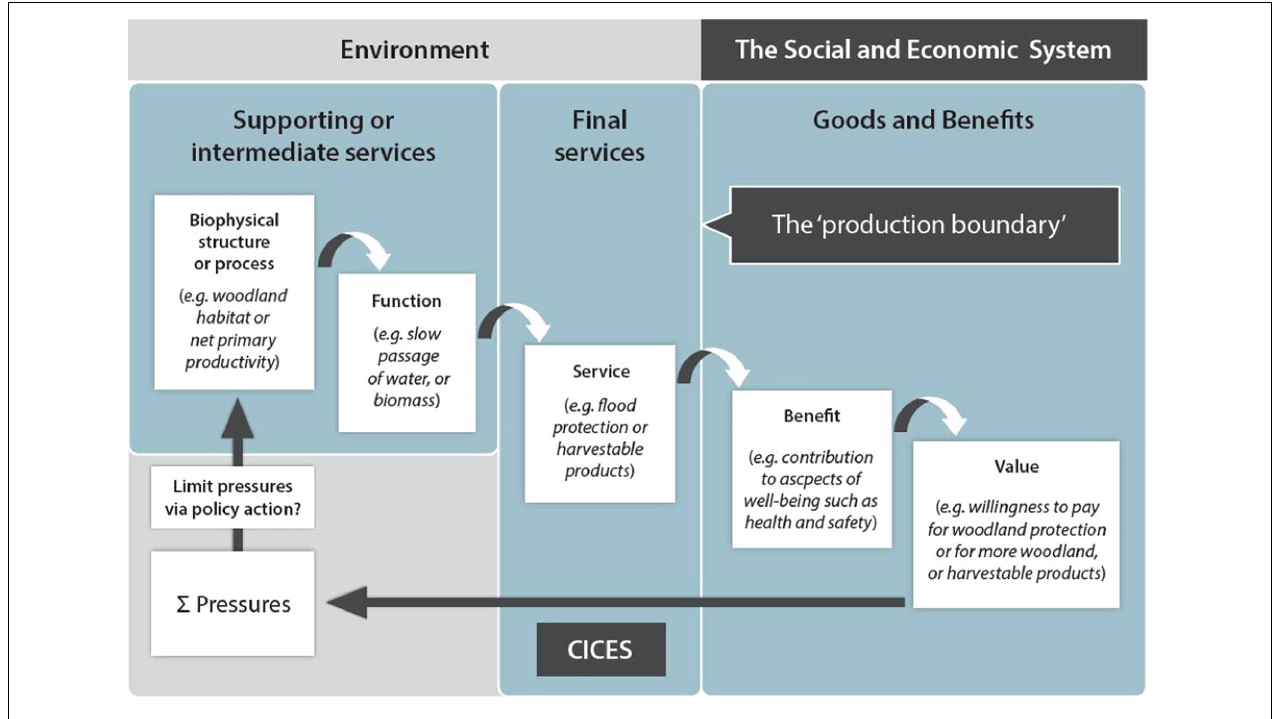
FIGURE 2 | Diagram of the ecosystem service cascade depicting the five constituents of the model. The diagram also shows the pressure of humans over the supporting services, and its possible regulation through the implementation of policy actions, e.g., via the Common International Classification of Ecosystem Services (CICES). Reproduced from Potschin and Haines-Young (2017); open access under the Creative Commons Attribution License - CC BY